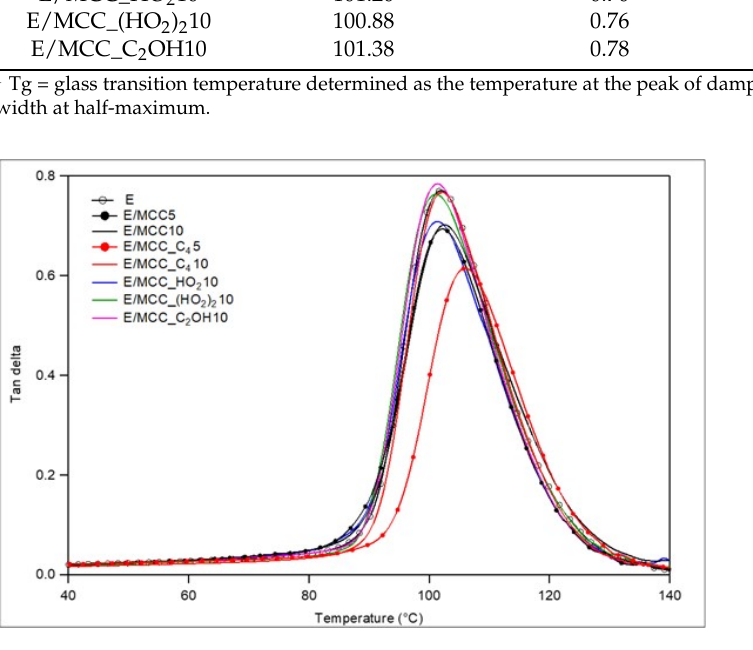
Figure 9. Damping curves for epoxy and the MCC/epoxy composites. Table 7. Damping curves-derived results for epoxy and the MCC/epoxy composites. Sample